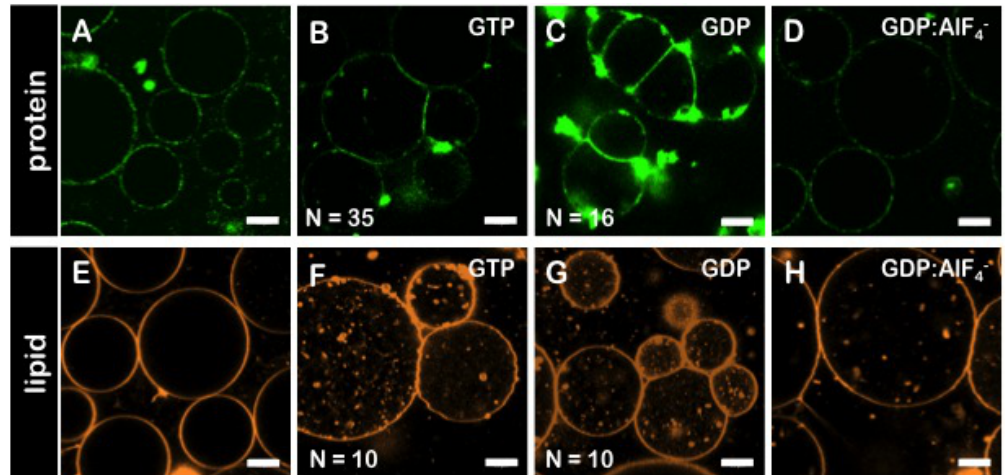
Figure 4. Membrane adhesion of GUVs promoted by hs Mfn1 . Confocal fluorescence micrographs of GUVs incubated with solubilised E. coli inner membranes carrying hs Mfn1 and the α -Mfn1-488 antibody (top row, protein channel). ( A ) in the absence of nucleotide, ( B ) in the presence of GTP, ( C ) GDP and ( D ) GDP:AlF − . The GDP:AlF − complex did not promote vesicle adhesion. Similar results were 4 4 obtained with GUVs labeled with RhoPE in the absence of α -Mfn1-488 and incubated with solubilised Mfn1-IMVs (bottom row, lipid channel). ( E ) in the absence of nucleotide, ( F ) in the presence of GTP, ( G ) GDP and ( H ) GDP:AlF − . The lipid composition of GUVs was POPC/DOGS-NTA 80/20 mol% 4 ratio. Scale bars are 10 µ m. Each condition was repeated independently at least 3